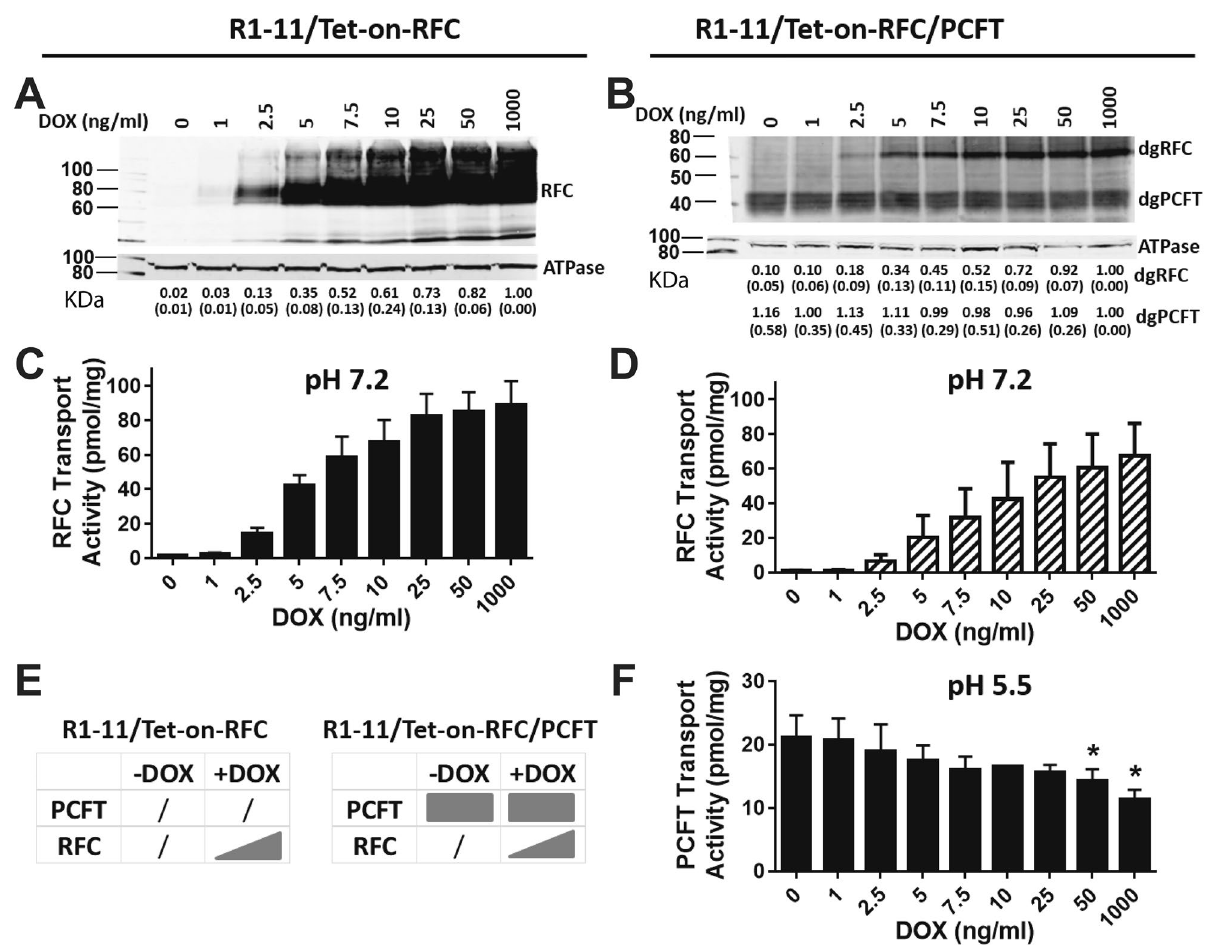
Figure 3. Characterization of R1-11/Tet-on-RFC single and R1-11/Tet-on-RFC/PCFT double transfectant models. R1-11/Tet-on-RFC or R1-11/Tet-on-RFC/PCFT cells were plated in 60-mm dishes in complete FF RPMI 1640 medium containing 10% FBS for transport and protein expression assays. Twenty-four hours later, a range of DOX (0, 1, 2.5, 5, 7.5, 10, 25, 50, and 1000 ng/ml) was added. After 48 h, RFC and PCFT protein levels for the R1-11/Tet-on-RFC ( A ) and R1-11/Tet-on-RFC/PCFT models (after deglycosylation; “dgRFC” and “dgPCFT” designate the deglycosylated forms of these proteins) ( B ) were measured in crude plasma membranes by SDS-PAGE and Western blotting with HA monoclonal antibody (upper panels), followed by stripping and re-probing with Na + /K + ATPase monoclonal antibody (lower panels) as a loading control. Blots were cropped as needed. The full blots are included in the Supplement (Figs. S6 to S9). The molecular mass markers for SDS- PAGE are noted. Densitometry was performed using the Odyssey software, and RFC or PCFT protein levels were normalized to Na + /K + ATPase and expressed relative to the level at the maximum concentration of DOX. Densitometry results are noted below the individual lanes and are presented as mean values plus/minus SDs from at least 3 experiments. RFC ( C , D ) and PCFT ( F ) transport activities were measured with [ 3 H]MTX at 37 °C for 2 min, at pH 7.2 and pH 5.5, respectively. Results are presented as mean values plus/minus SDs from at least 3 experiments. Statistical significance of PCFT transport activities between samples with and without DOX was analyzed by the unpaired t test. An asterisk indicates a statistically significant difference between the mean values of PCFT transport ( p < 0.05). A schematic is shown depicting the expression of RFC in R1-11/Tet-on- RFC cells, and RFC and/or PCFT in R1-11/Tet-on-RFC/PCFT cells, in the presence or absence of DOX ( E